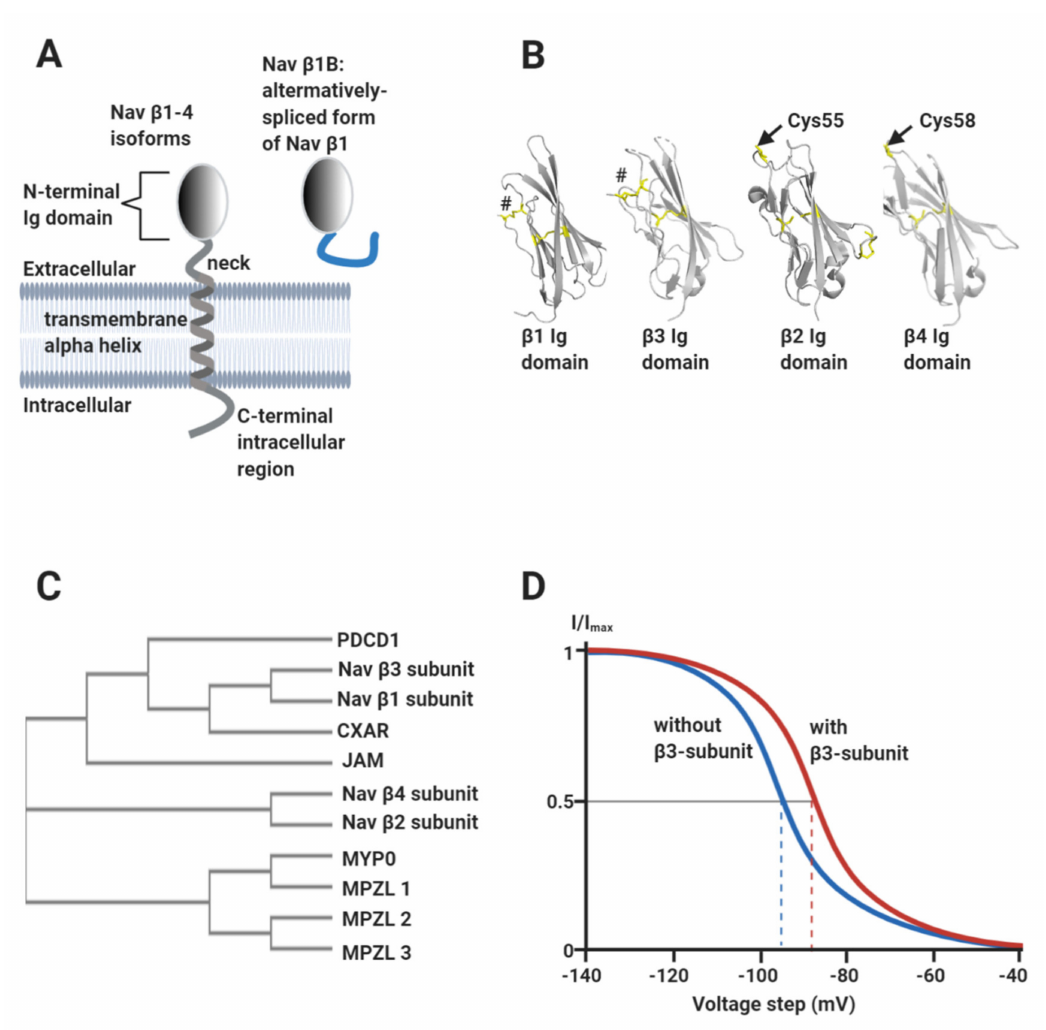
Figure 3. The Nav channel β -subunits. ( A ) Cartoon showing the common structural features of the β -subunits, including the alternatively spliced β 1B isoform. ( B ) Atomic-resolution structures for the Ig domains of: β 1 (PDB: 6JHI); β 2, (PDB: 5FEB); β 3 (PDB: 4L1D) and β 4 (PDB: 5XAX). The separate disulphide bonds stabilising the N-terminal strands of β 1 and β 3 are labelled by hashtags and the free, exposed Cys residue on β 2 (Cys55) and β 4 (Cys58) are as indicated. ( C ) Phylogenetic analysis of Nav channel β -subunits, showing their relationship to members of the Ig domain-containing CAM protein family. PDCD1: programmed cell death protein 1 (https: // www.uniprot.org / uniprot / Q15116); CXAR: Coxsackievirus and adenovirus receptor (https: // www.uniprot.org / uniprot / P78310); JAM: junctional adhesion molecule 2 (https: // www.uniprot.org / uniprot / P57087); MYP0: myelin protein P0 (https: